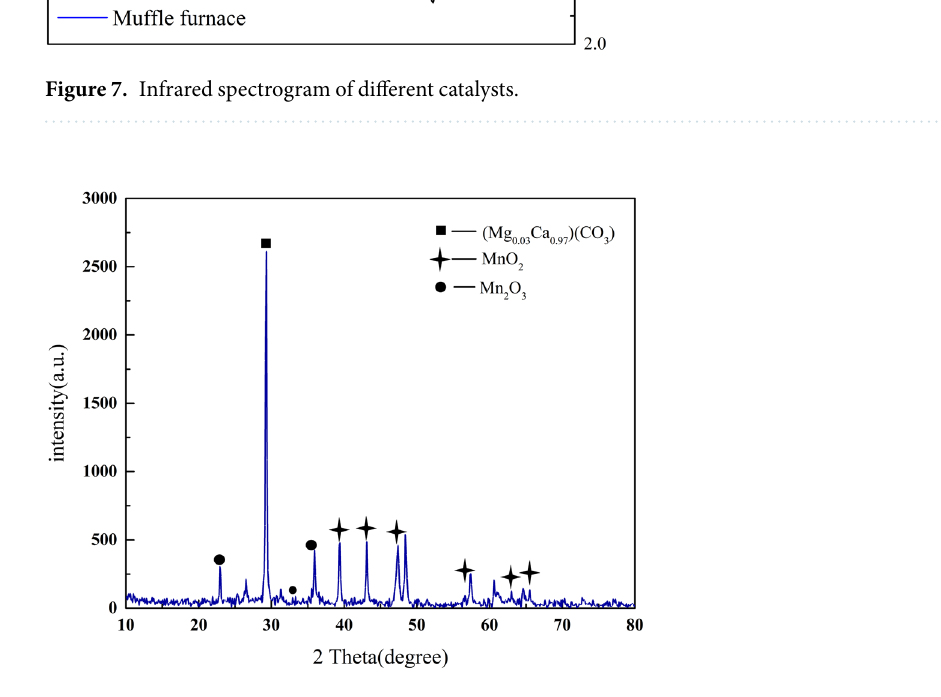
Figure 8. XRD spectrogram of MnOx-based sludge calcined by muffle